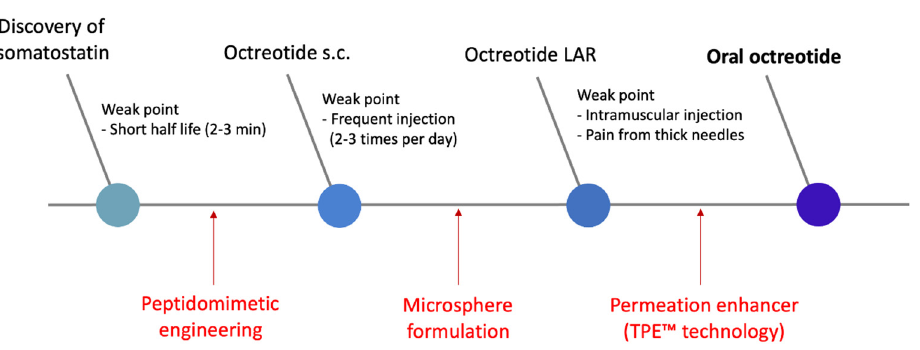
Figure 1. The historical chart of the octreotide formulation development process.